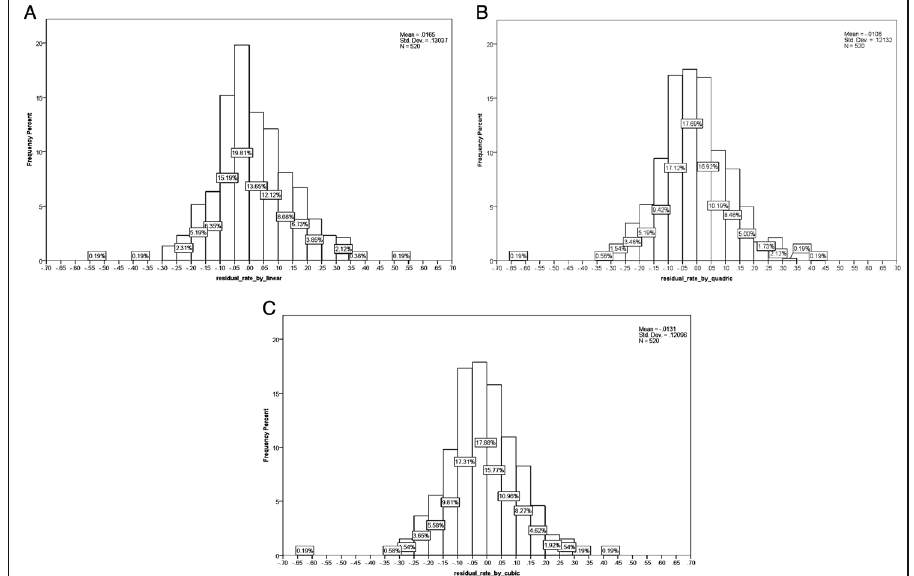
Fig. 4 Residual rate histograms: linear a , quadratic b , and cubic c